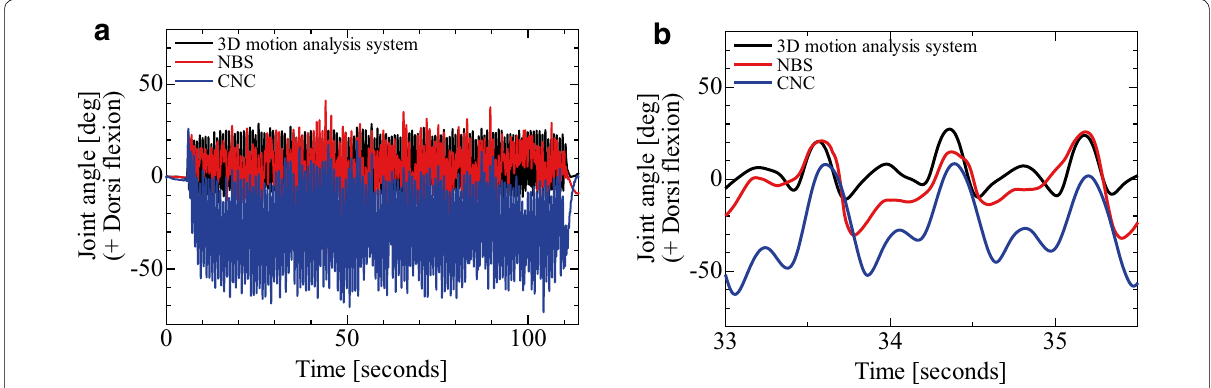
Fig. 4 Results obtained for ankle joint angles (Subject A). a The results over the entire measurement time. b The results between 33 and 35.5 s.